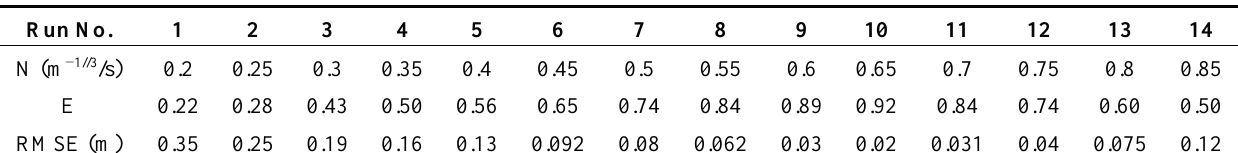
6. Model performance parameter as per different single friction roughness